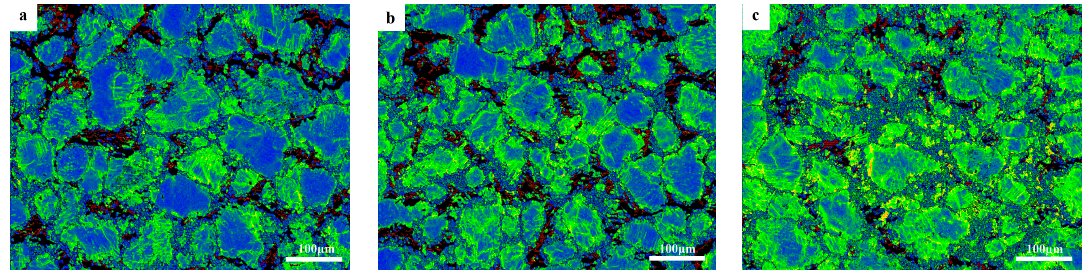
Figure 12. ( a – c ) KAM (Kernel Average Misorientation) maps of the side, middle, and heart parts at a strain rate of 0.001 s − 1 , respectively.